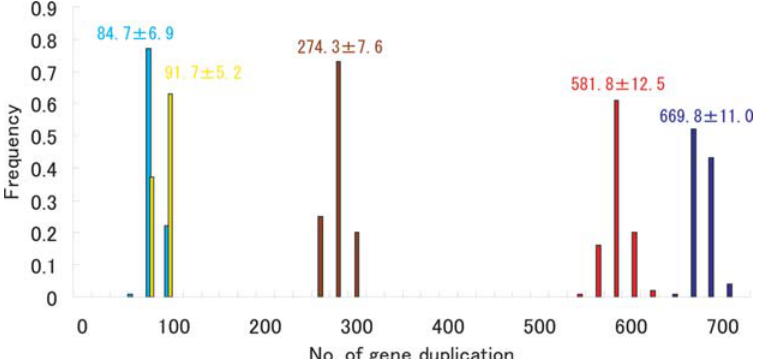
Figure 2. The number of gene duplications before the Amphibia-Mammalia (light blue bars), birds-Mammalia (yellow bars), Monotremata-Placentalia (brown bars), Marsupialia-Placentalia (red bars) and Laurasiatheria-Euarchontoglires (blue bars) split, based on the bootstrap analysis. Mean 6 standard deviation is shown in the figure. The detailed data for mammals are shown in Table S2.